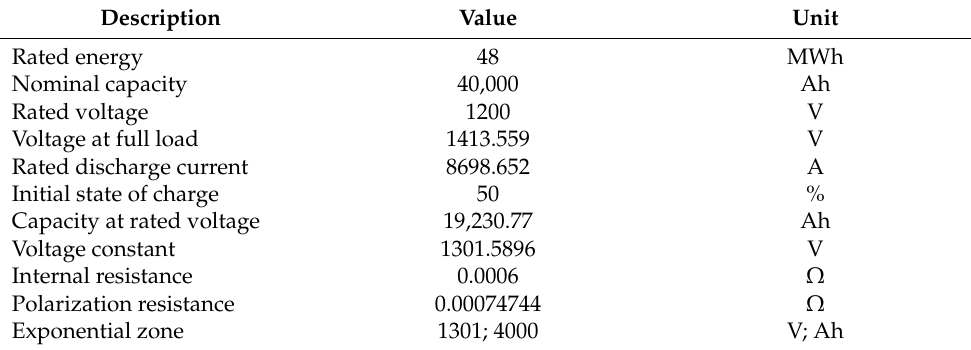
Table A3. BESS parameters (battery bank).